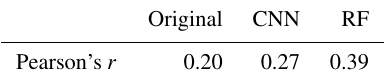
Table 4. Pearson’s r correlation coefficient between the topsoil and subsoil TC for the original measurements of the test set, the pre- dicted TC by the CNN and the predicted TC by the RF